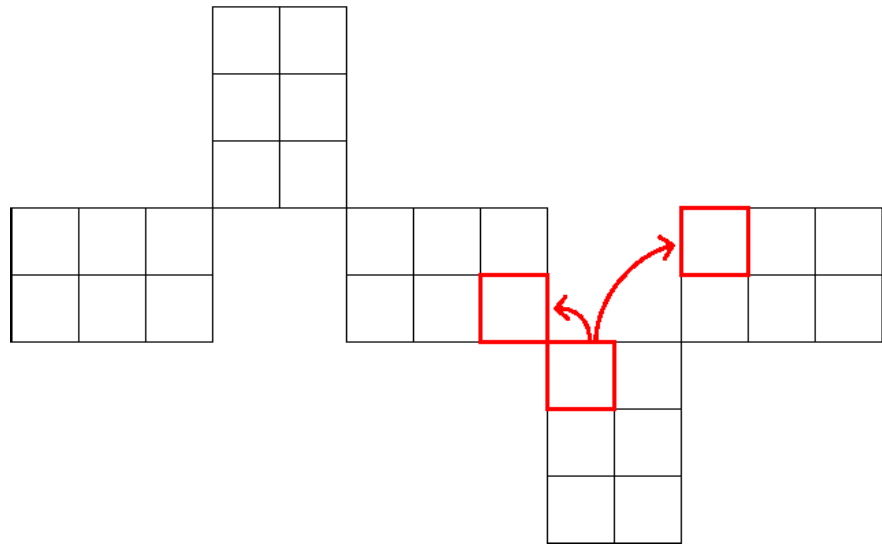
Figure 2. Cell representation of a shared lane with simultaneous left- and right-turn movements.